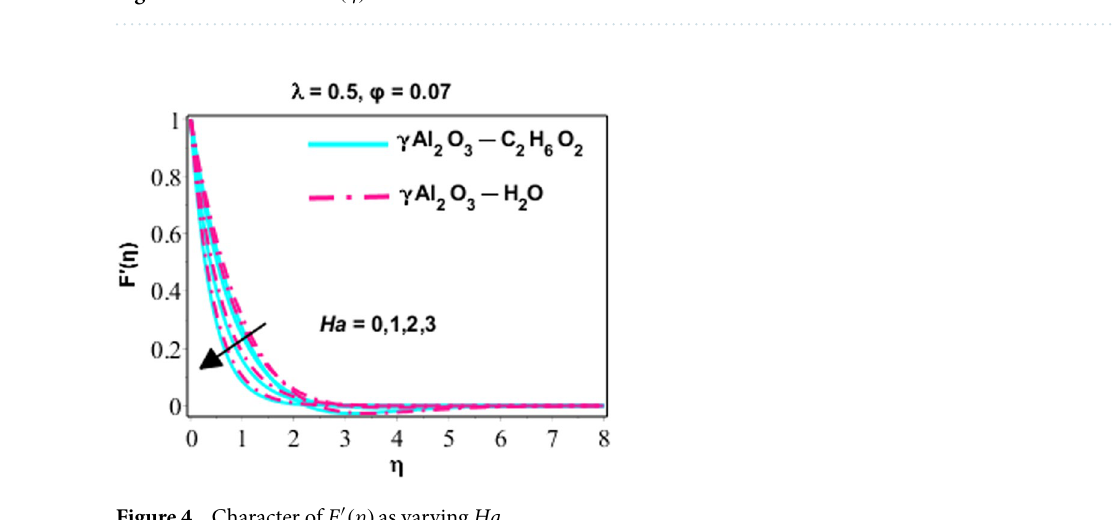
Figure 3. Behavior of F ′ (η) due to the variation in (cid:31) .